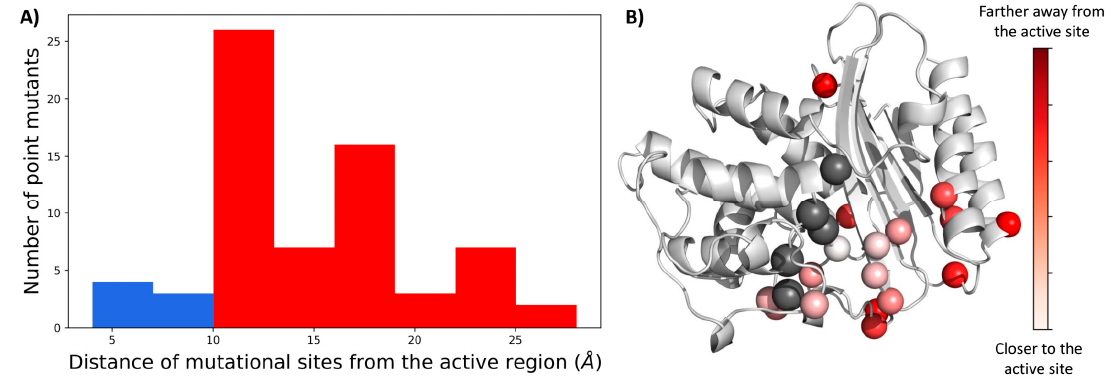
Figure 1. ( A ) Distribution of the distance of mutational sites in single point mutations observed in clinical isolates and laboratory evolution experiments in wild type TEM-1 β -lactamase around the active site. It was observed that the majority of the mutations were distal to the active site (i.e., >10 Å shown in red) and hence impacted the function via allosteric interactions. On the other hand, a very small number of variants were observed where mutational sites were closer to the active site (in blue) ( B ) Cartoon representation of TEM-1 with active sites in black spheres and the mutational sites studied in colored spheres, where the color depends on their distance from the centroid of the catalytic region.